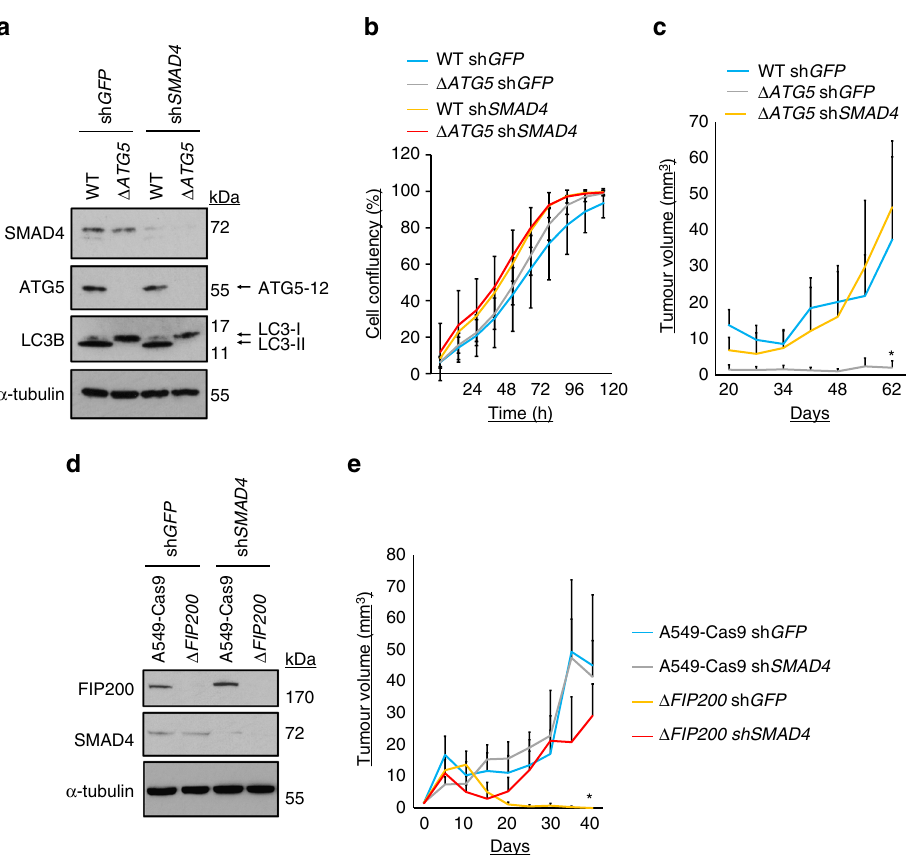
Fig. 8 Inhibition of SMAD4 rescues the effects of autophagy loss in vivo. a A549 WT and Δ ATG5 cells were transduced with control non-targeting shRNA (sh GFP ) or shRNA targeting SMAD4 (sh SMAD4 ). Stable lines were immunoblotted as indicated. b Cells were plated for time-lapse phase-contrast videomicroscopy using an Incucyte microscope and cell proliferation was monitored by automated con fl uency analysis at set intervals post plating ( n = 9 wells, ± S.D.). c Cells were subcutaneously injected into immunocompromised mice and tumour volume was monitored longitudinally (means, n = 10 fl anks, ± S.E.M., * P < 0.05 vs. WT sh GFP , two-tailed t -test). d , e A549-Cas9 and cognate A549 Δ FIP200 cell lines were transduced with sh GFP or sh SMAD4 . Selected pools were d immunoblotted as indicated or e subcutaneously injected into immunocompromised mice, whereupon tumour volume was monitored longitudinally (means, n = 8 fl anks, ± S.E.M., * P < 0.05 vs. all other conditions, two-tailed t -test). Uncropped blots are available